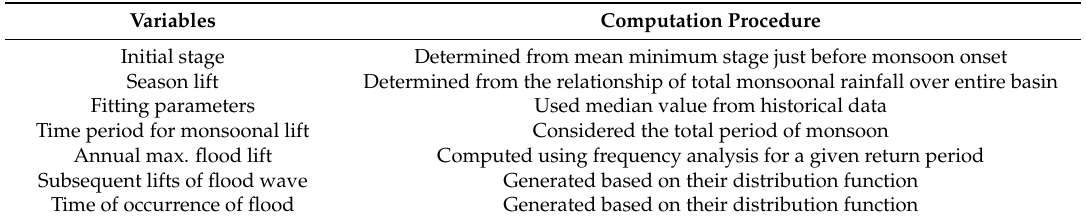
Table 1. Details of different parameters with a brief